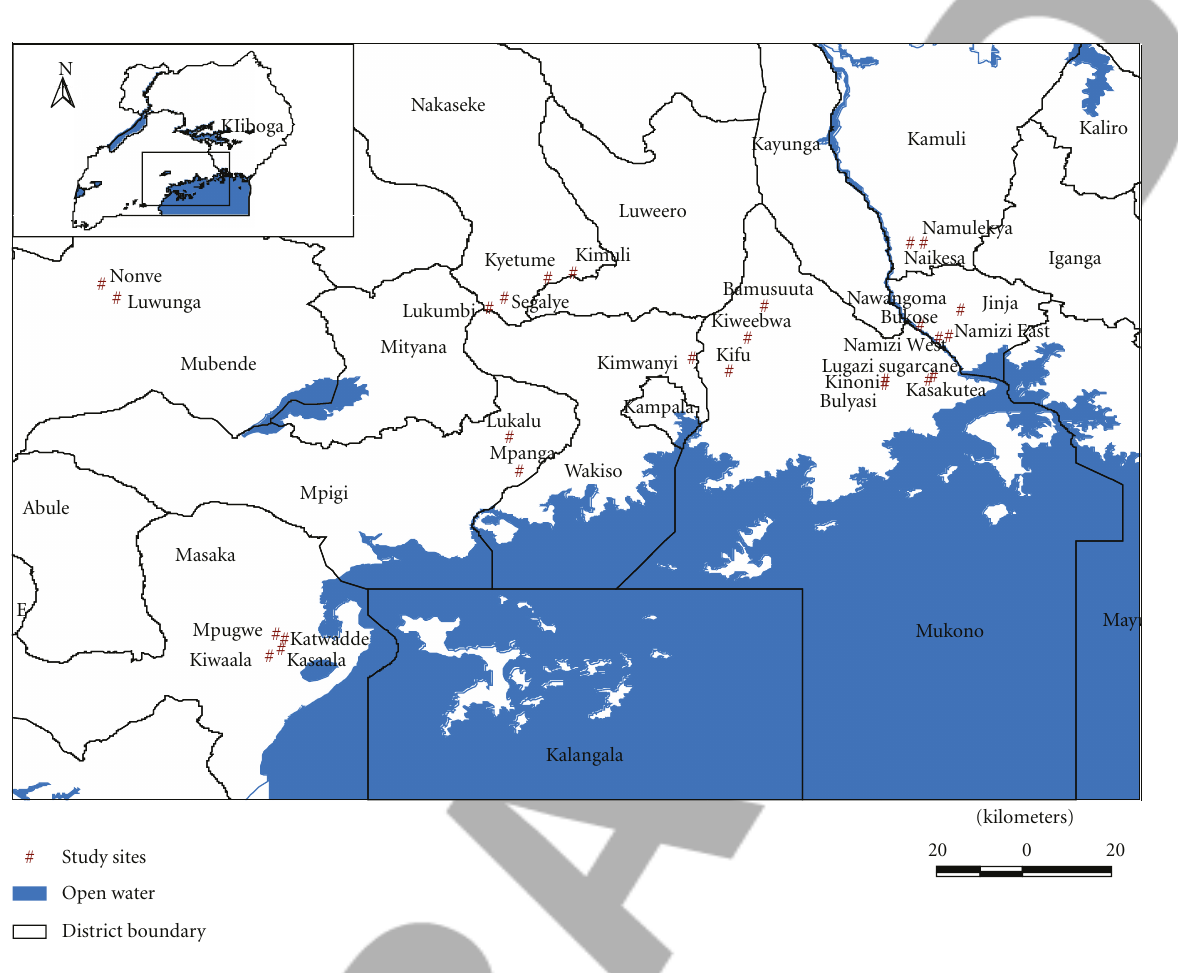
Figure 1: Location of study sites in which bee fauna survey was conducted in the banana-coffee growing area around Lake Victoria in Uganda in